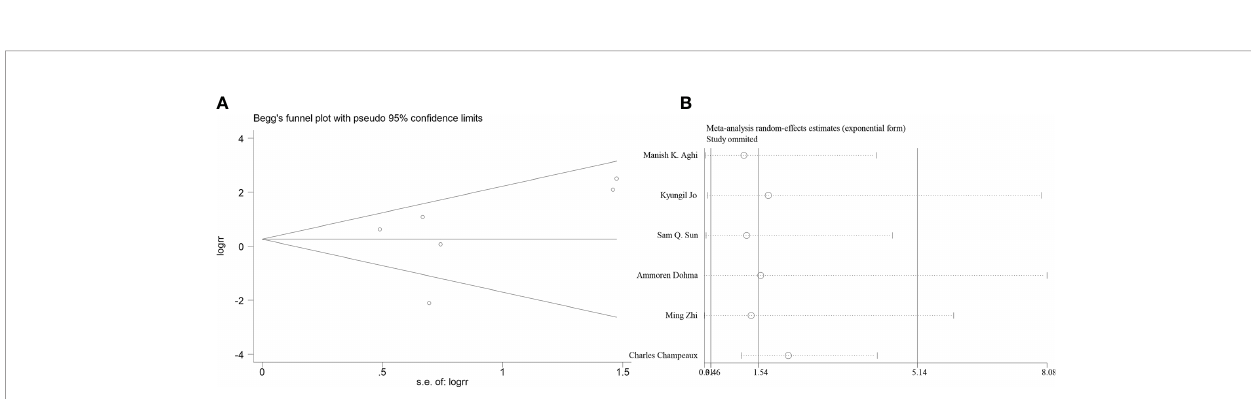
FIGURE 3 | (A) Forest plot for the relationships between PORT and 5-year OS. (B) Begg ’ s funnel plots of publication bias for meta-analysis of PORT. (C) Sensitivity analysis for meta-analysis of